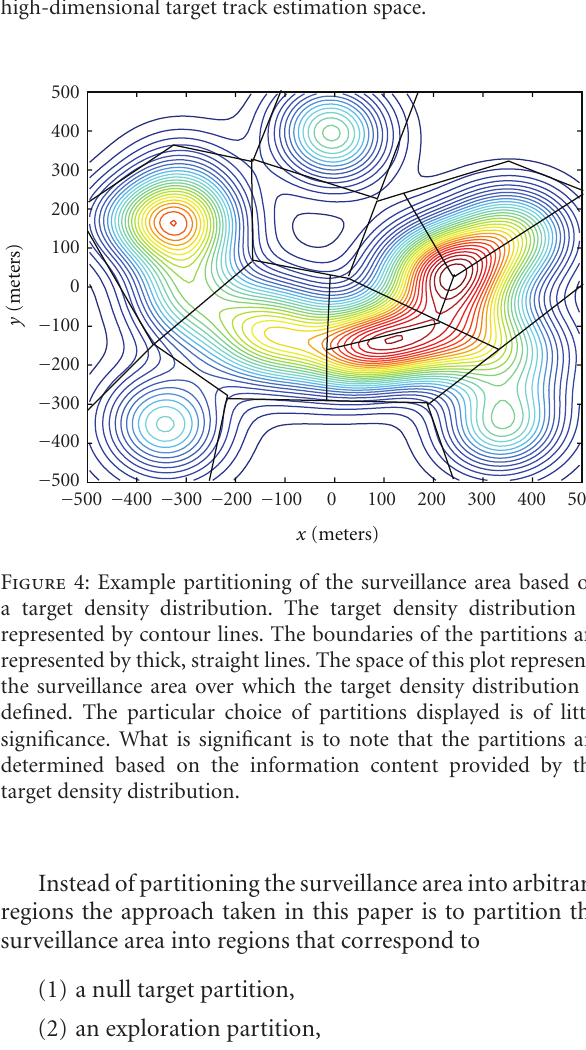
Figure 3: Sample target density distribution, represented by con- tour lines, defined over a surveillance area. The details of this dis- tribution’s shape are not important. What is important is to note that a target density distribution captures the complexity of the high-dimensional target track estimation space.